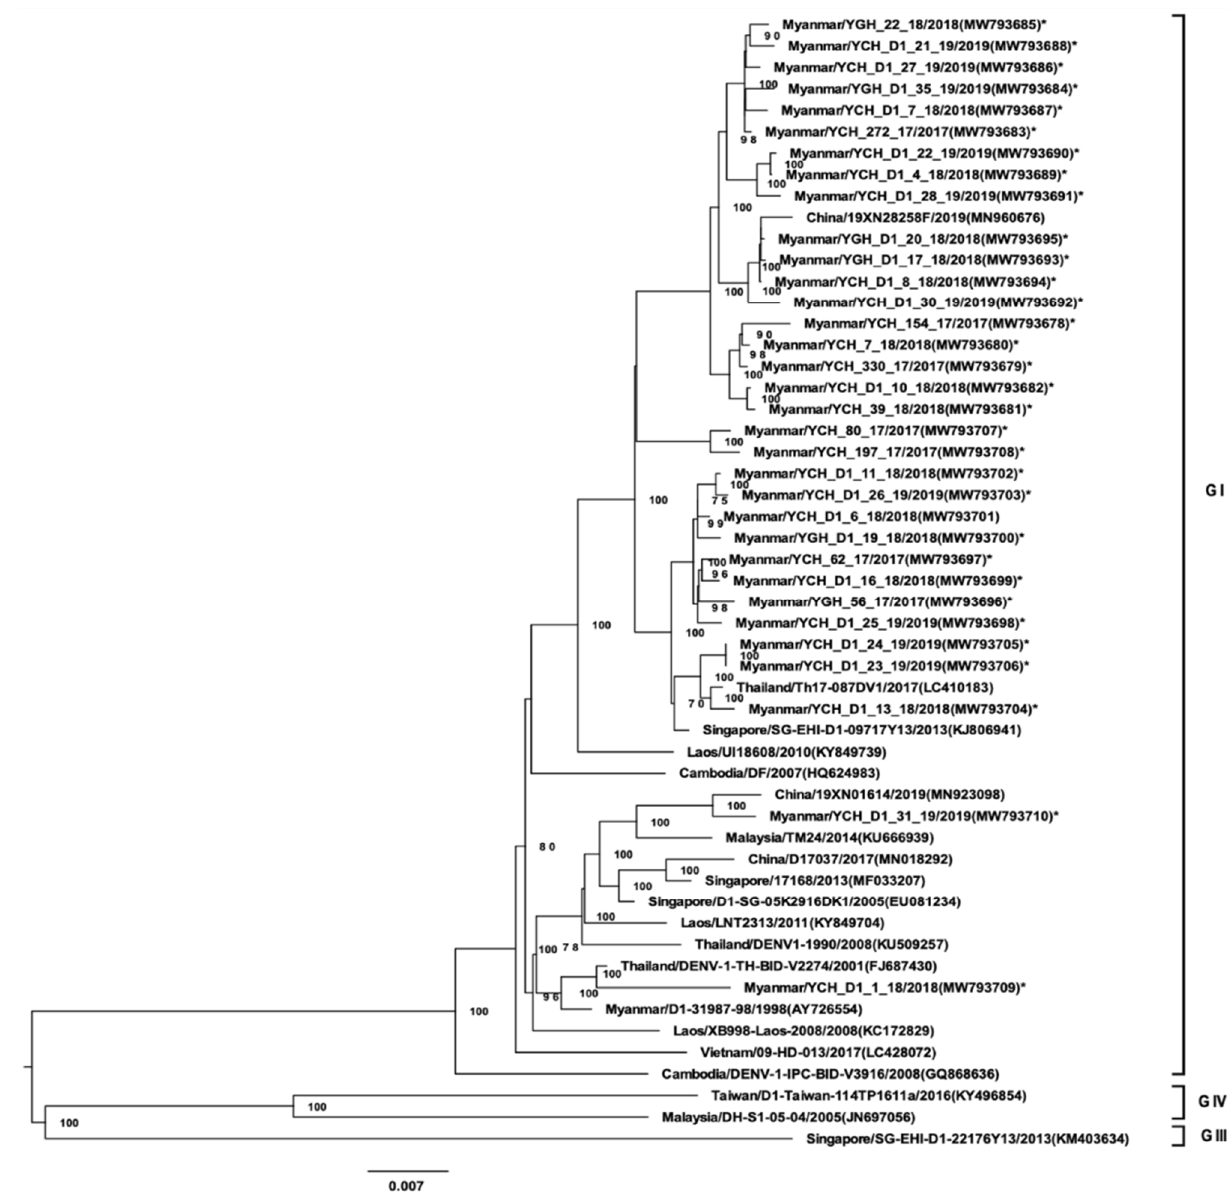
Figure 1. Phylogenetic tree of DENV-1 based on whole-genome sequencing. The maximum likelihood tree was generated using a general time reversible GTR+I+G model with 1000 bootstrap replicates. Bootstrap values of >70 were indicated in the nodes. The tree shows global DENV strains, and the 33 DENV-1 isolates from this study (indicated by asterisks). These and representative strains of each genotype are named by country of origin, strain name, year of isolation, and accession number (GenBank).